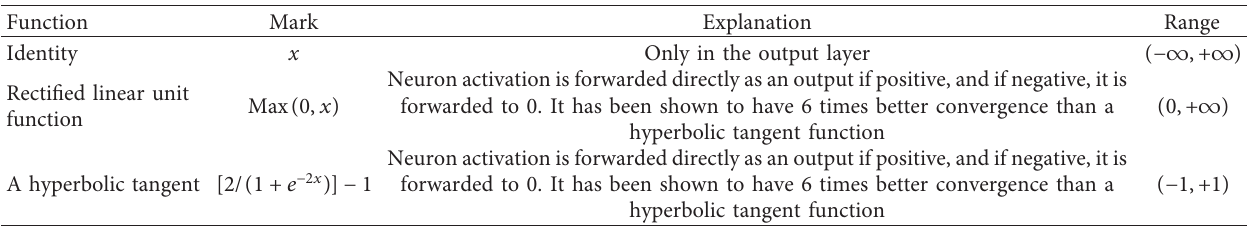
Table 4: Activation functions of a multilayer perceptron model of the artificial neural